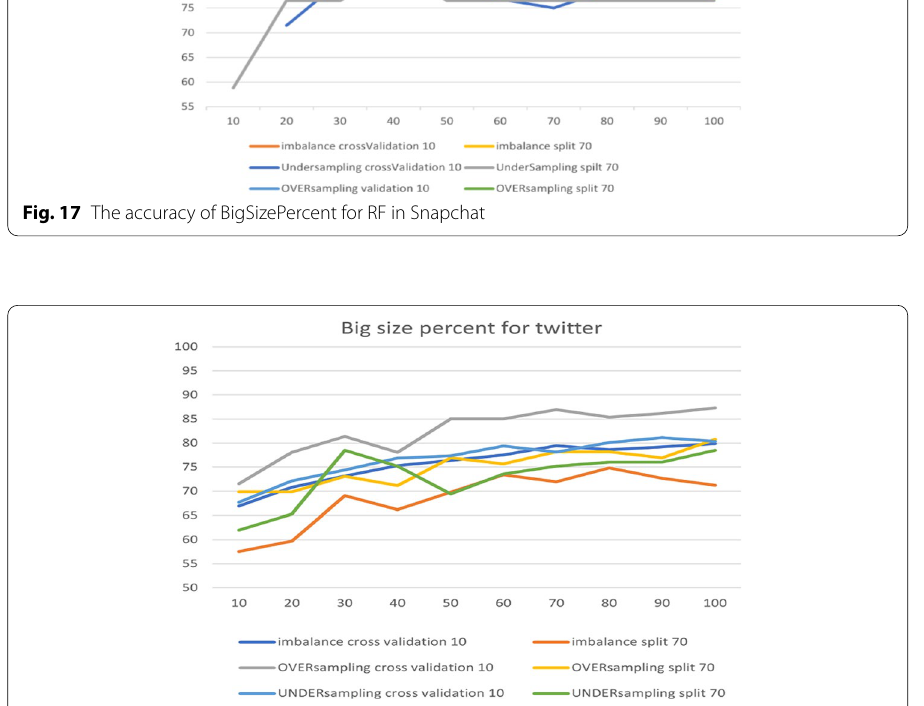
Fig. 18 The accuracy of BigSizePercent for RF in Twitter